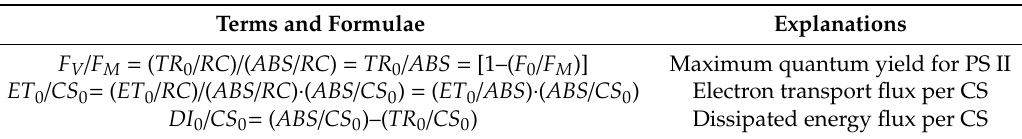
Table 3. JIP-test (Analysis of the Chlorophyll Fluorescence Transients) parameters with interpretations and formulae calculated using fluorescence transient